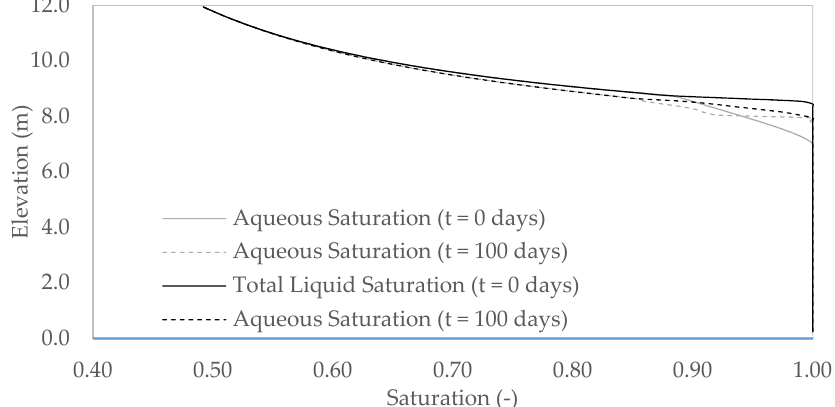
Figure 9. Aqueous and total saturation variation (initial and final) in TE6 under 24.93 kPa for silty